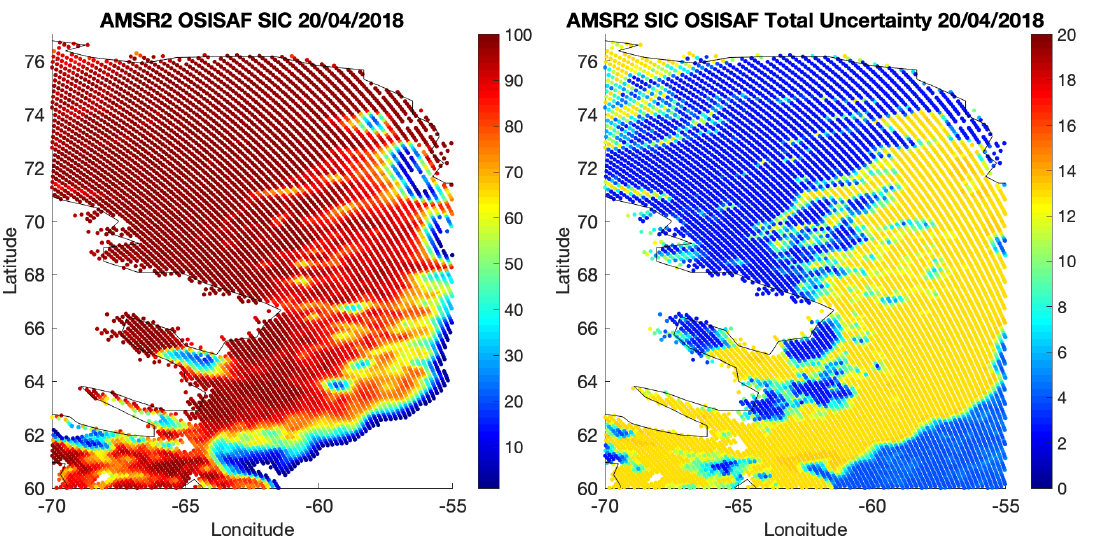
Figure 3. The Ocean Sea Ice—Satellite Application Facilities (OSI SAF) results for the selected scene, 20 April 2018. Left: the sea ice concentration (SIC). Right: the total uncertainty on that product (the sum of the algorithm and smearing